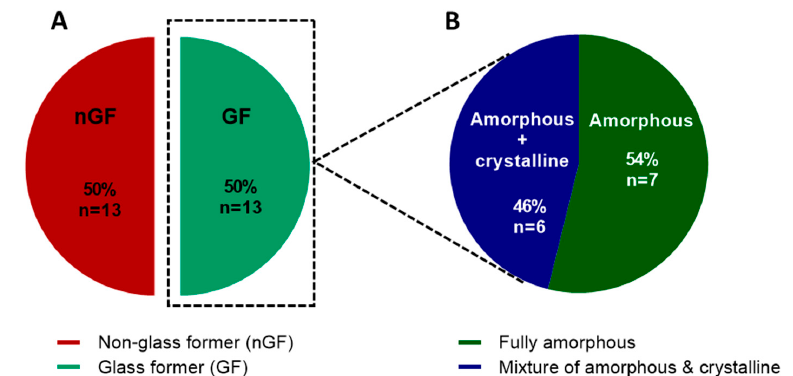
Figure 1. Pie charts showing ( a ) the glass-forming ability (GFA) of the model compounds produced via a standard spray-drying method and ( b ) the solid-state forms of the glass formers (GFs). The spray-dried compounds were classified as either non-glass formers (nGFs) or GFs. The GFs were further divided as either producing fully amorphous or a mixture of amorphous and crystalline material.